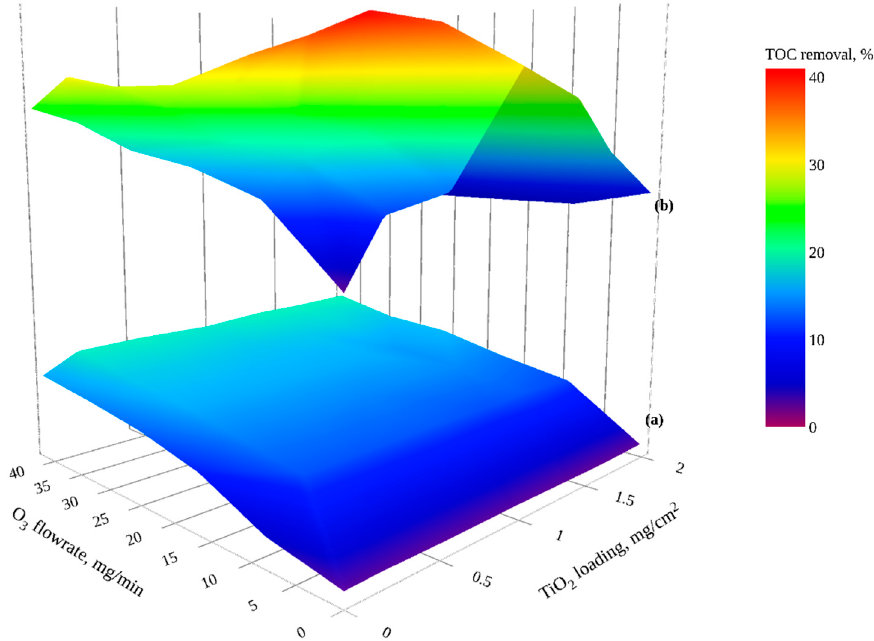
Figure 4. TOC reduction by ( a ) ozonation and catalytic ozonation and ( b ) Ozone photolysis and photocatalytic ozonation, examined with different ozone flowrate (0–41.7 mg O 3 /min) and a range of catalyst loading (0–1.98 mg TiO 2 / cm 2 ) (interactive plots presented in Figures S4 and S5).